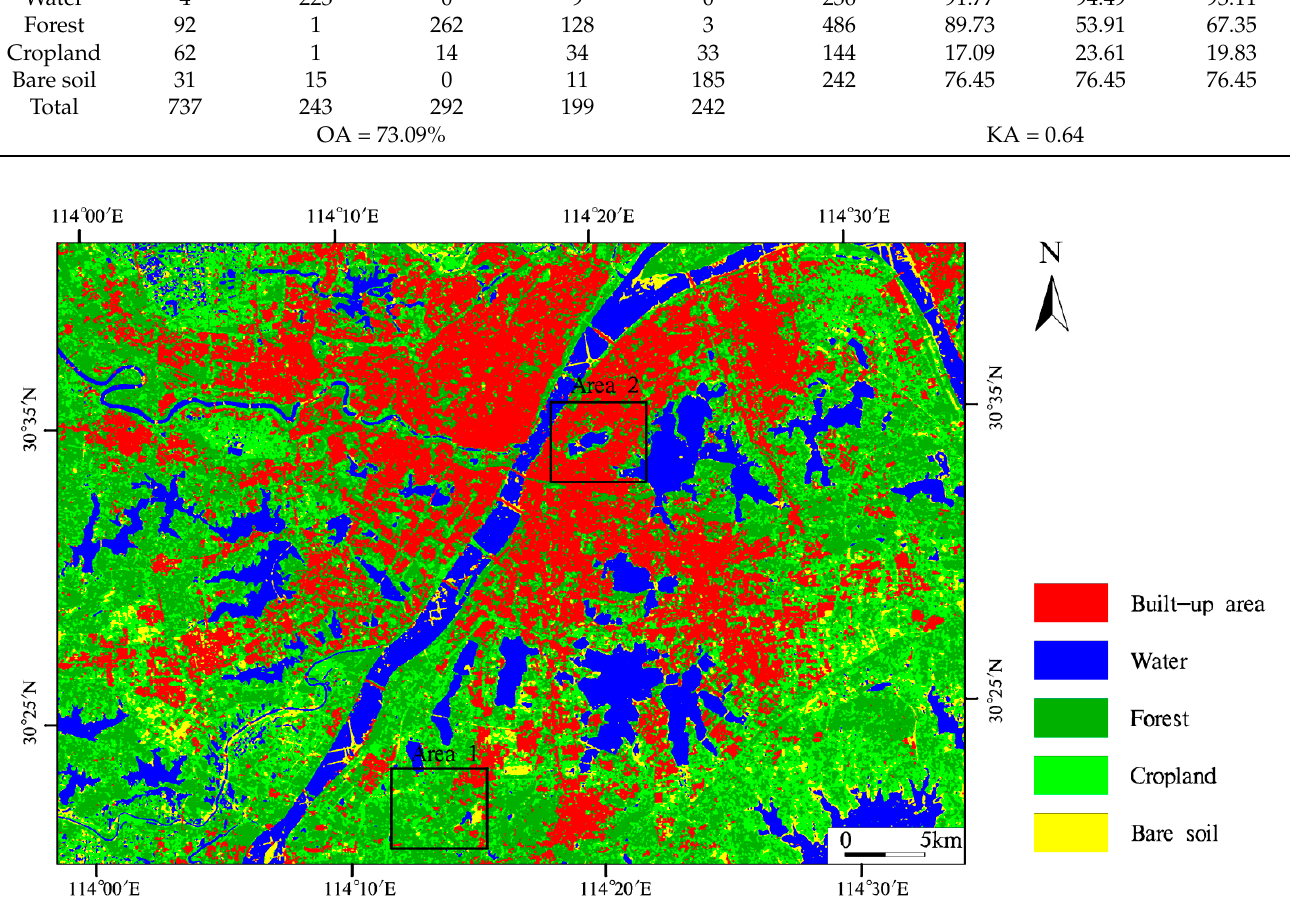
Figure 5. Land cover map obtained from the SVM-CK algorithm with the Sentinel-1A SAR image.